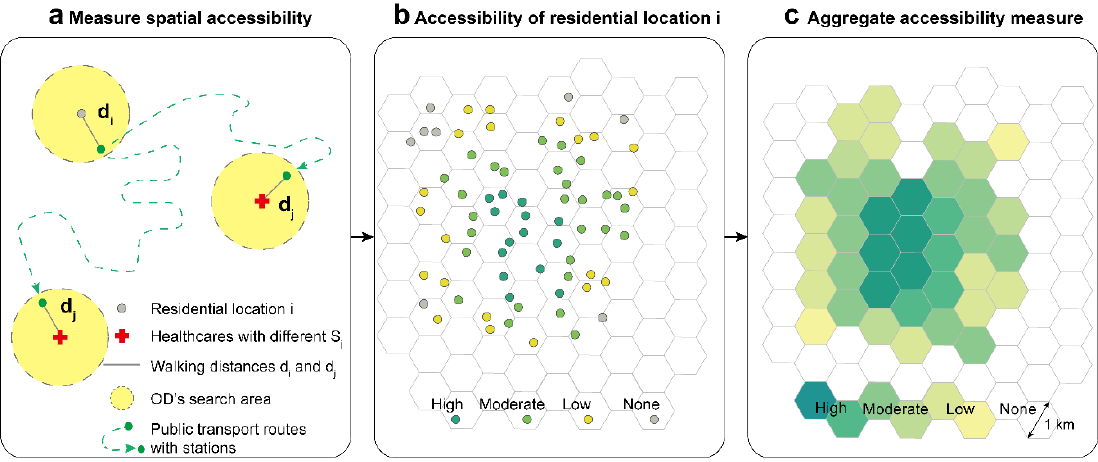
Figure 2. Schematic diagram of measurement of spatial accessibility to healthcare services: ( a ) measure spatial accessibility; ( b ) the accessibility of residential location i; ( c ) aggregate accessibility measure.